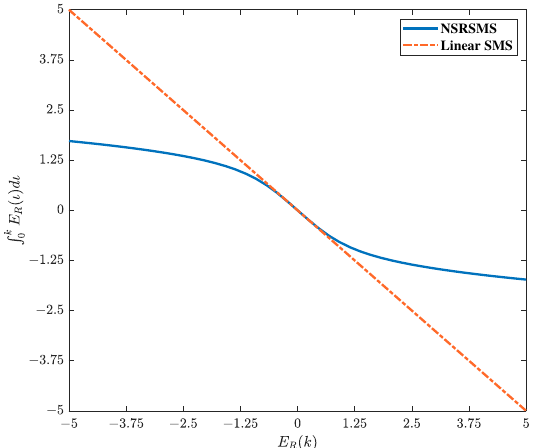
Figure 4. Comparison of NSRSMS and linear sliding mode